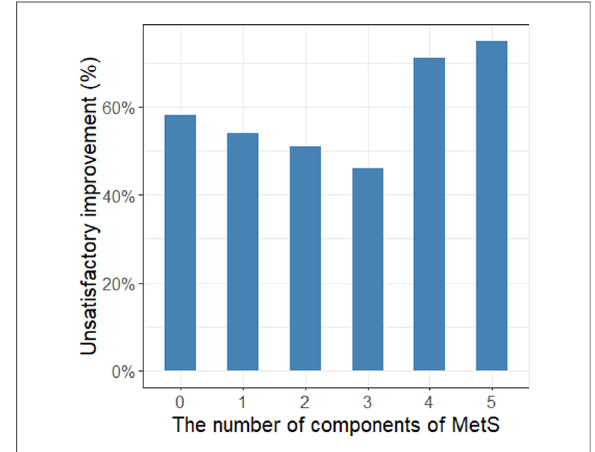
FIGURE 1 The association between the number of components of MetS and unsatisfactory improvement in